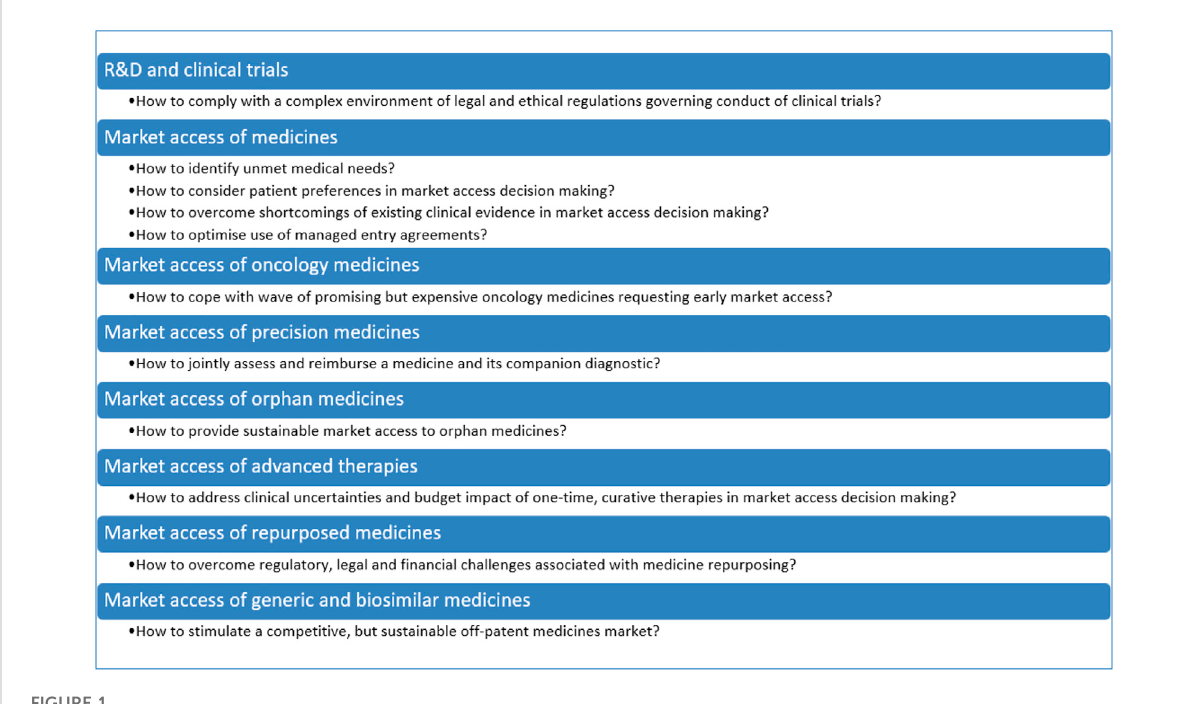
FIGURE 1 Challenges in balancing valuable innovation with affordable access to medicines.